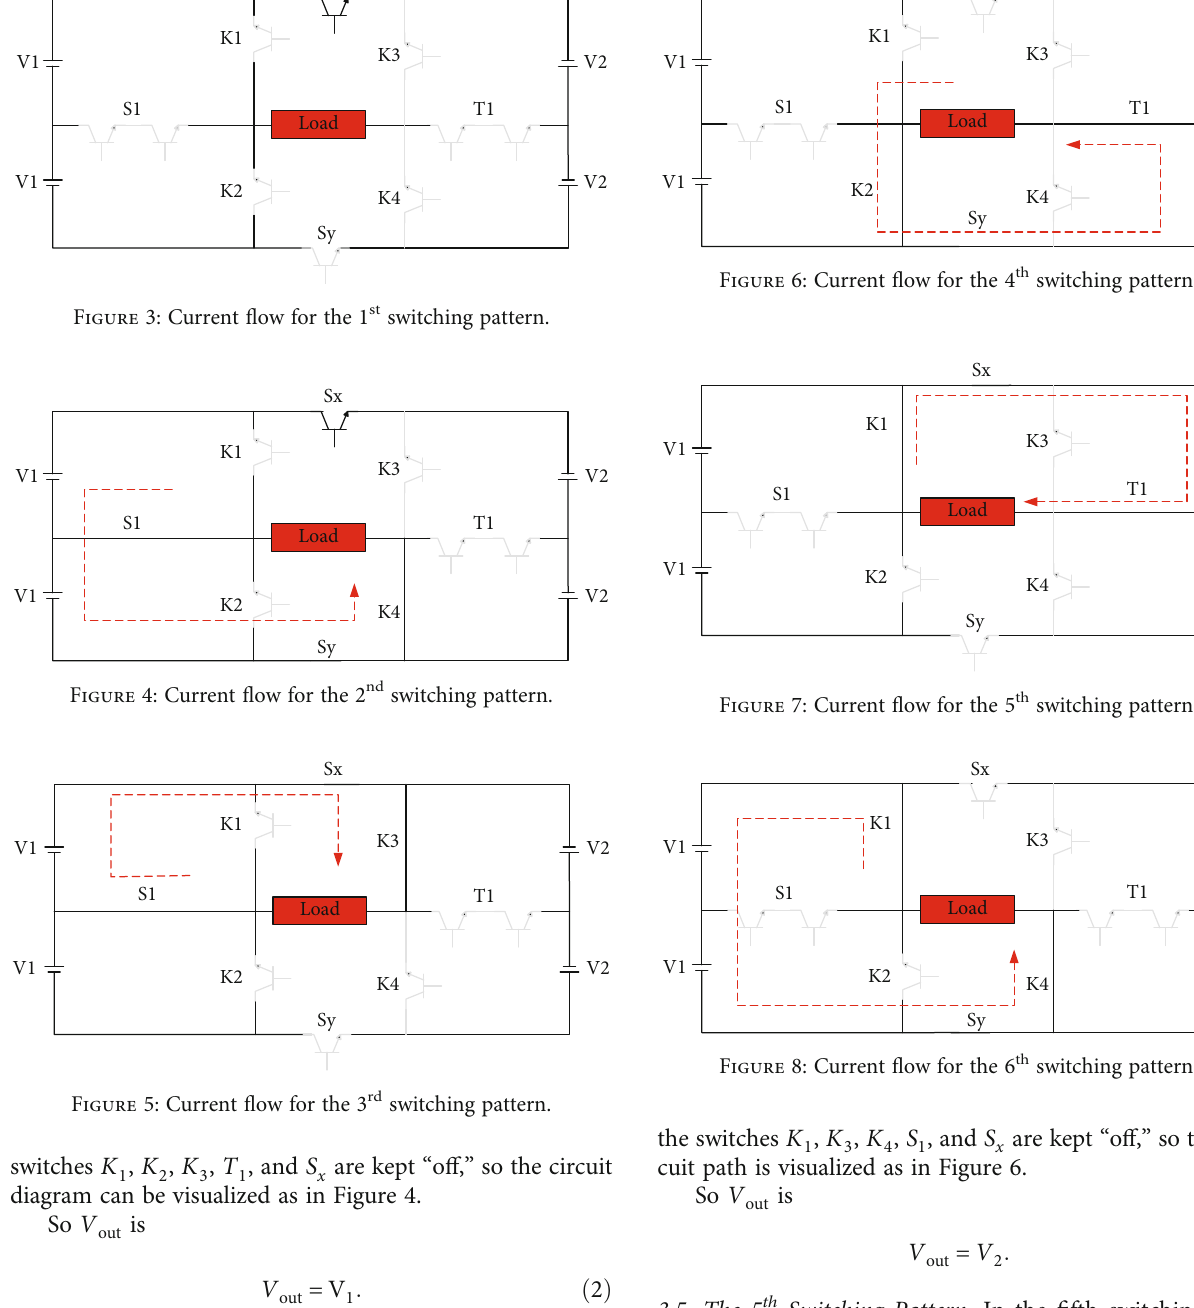
Figure 5: Current fl ow for the 3 rd switching pattern.